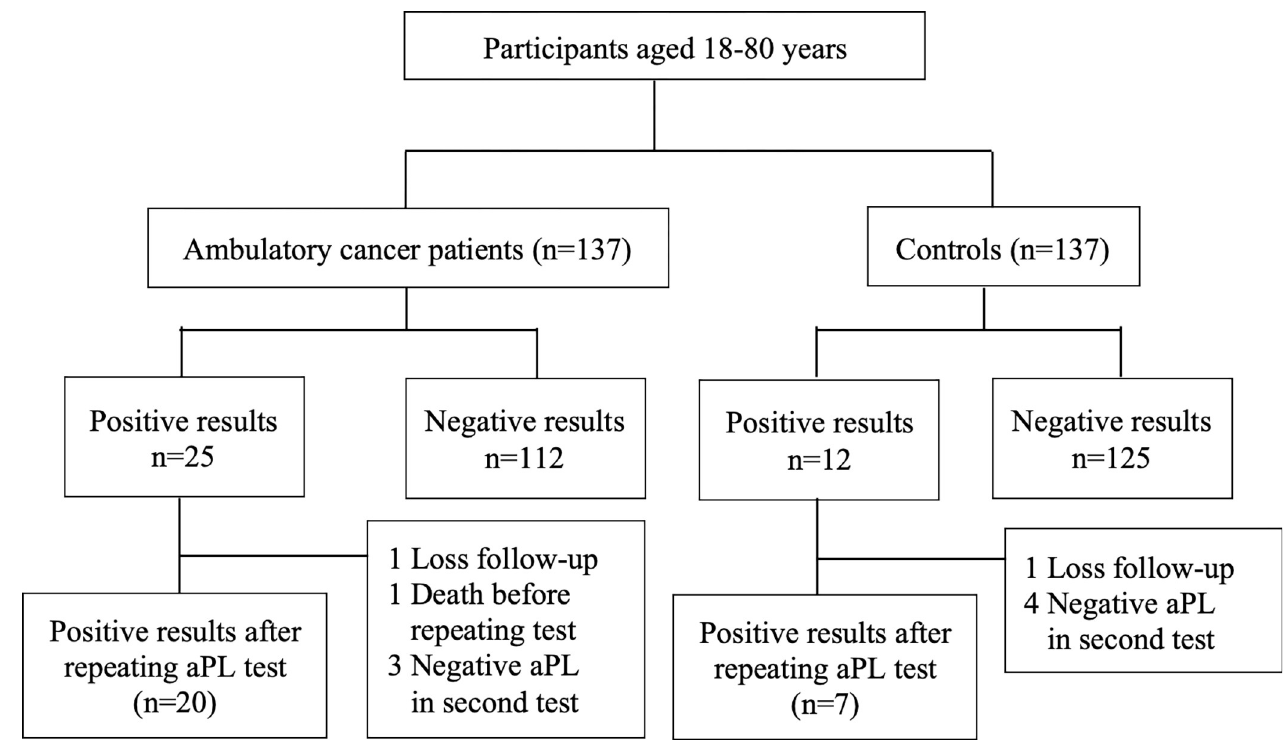
Fig 1. Flow diagram of participants in the